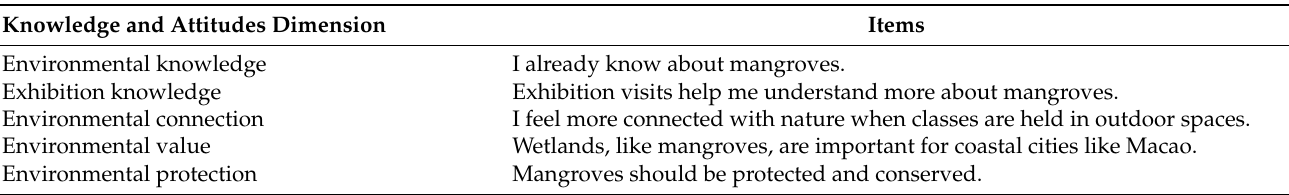
Table 2. Items on knowledge and